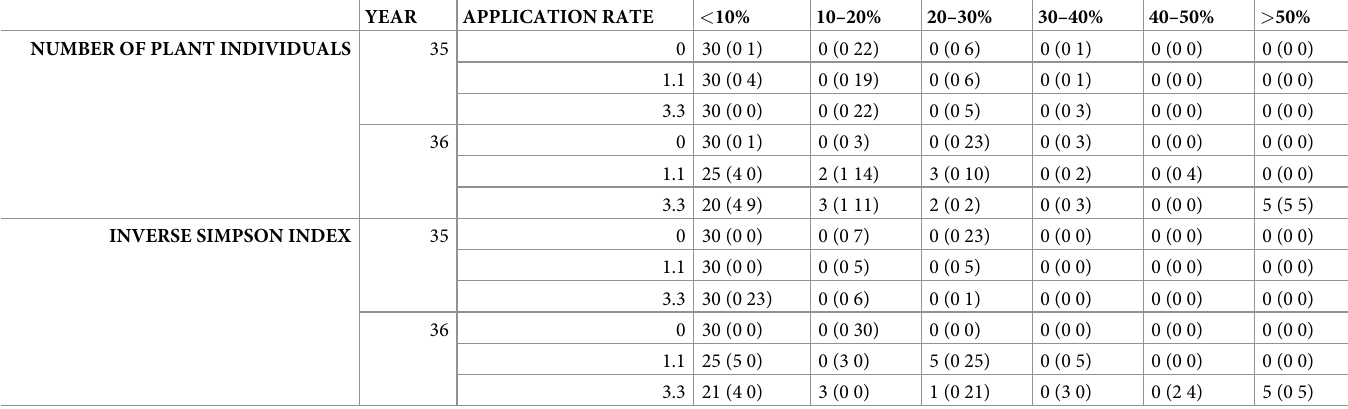
Table 5. Number of weeks in which the mean (minimal and maximal) negative effect on the number of plant individuals and the inverse Simpson index is within a certain effect class. As IBC-grass simulates only 30 weeks of growing period, the maximal number of weeks is 30. The simulated herbicide application started in year 36. Numbers in brackets represent the number of weeks in which the minimal and maximal values are within a certain effect class. Please note, that only negative effects are considered in this table. Positive impacts can be observed in Figs